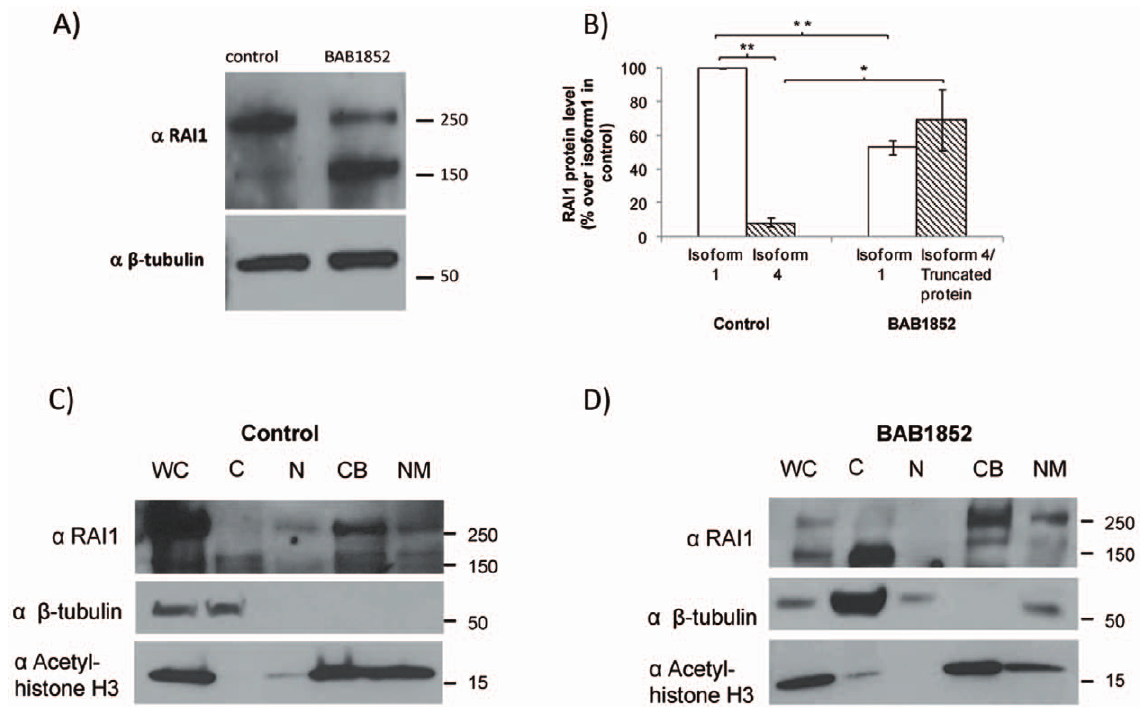
Figure 3. Evaluation of RAI1 expression in lymphoblastoid cells. A) Western Blot for RAI1 expression in lymphoblastoid cells from patient BAB1852 and normal control. B) A band densitometric analysis of RAI1 isoforms was performed, and the percentages compared to the isoform 1 in cells from the control are shown. The band of , 170 kDa found in patient cells represents truncated RAI1 isoform 1 and RAI1 isoform 4 proteins as a result of their similar molecular weight. (n=4 for both samples, * p=0.02; ** p # 1.78*10 2 6 ). Subcellular localization of RAI1 in C) control or D) BAB1852 lymphoblastoid cells. Whole Cell (WC), Cytoplasmic (C), Nuclear soluble (N), Chromatin Bound (CB) and Nuclear Matrix (NM) fractions were obtained from control or BAB1852 lymphoblastoid cells. RAI1 isoform 1 is mainly associated with chromatin and nuclear matrix. The antibodies Acetyl-histone H3 antibody ( a Acetyl-histone H3, chromatin bound protein marker) and beta-tubulin antibody ( a b -tubulin, cytoplasmic soluble fraction marker) were used as controls of the protocol for cell